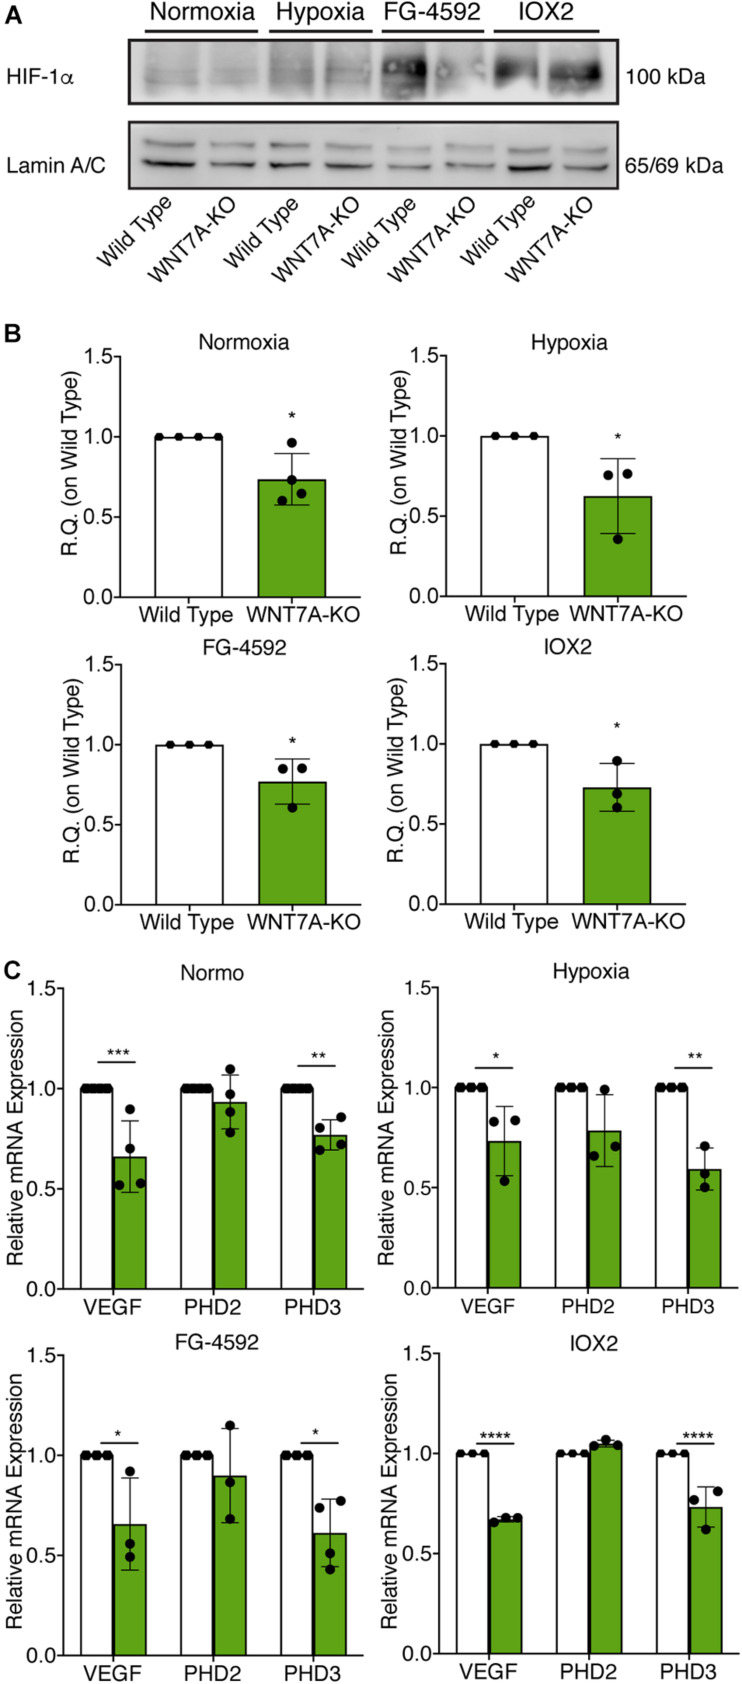
Modulation of hypoxia inducible factor-1α (HIF-1α) pathway induced by WNT7A silencing upon physical and pharmacological hypoxia. (A,B) Western blot analysis (A) and relative quantification (B) of HIF-1α nuclear localization in wild type (WT) and WNT7A-silenced murine myoblasts (WNT7A-KO) treated under normoxia, hypoxia, FG-4592 or IOX2. The nuclear marker Lamin A/C was used as the housekeeper (n = 4 for Normoxia, n = 3 for Hypoxia, IOX2 and FG-4592). (C) qPCR analysis of HIF-1α target genes, VEGF, PHD2, and PHD3 in WT and WNT7A-silenced murine myoblasts (WNT7A-KO) upon physical and pharmacological hypoxia (n = 4 for Normoxia, n = 3 for Hypoxia, IOX2 and FG-4592). Data information: all data represent mean ± SD. For western blot analysis of HIF-1α *p < 0.05 (Student’s t-test). For qPCR analysis of HIF-1α target genes *p < 0.05, **p < 0.01, ***p < 0.001, ****p < 0.0001 (ordinary one-way ANOVA).